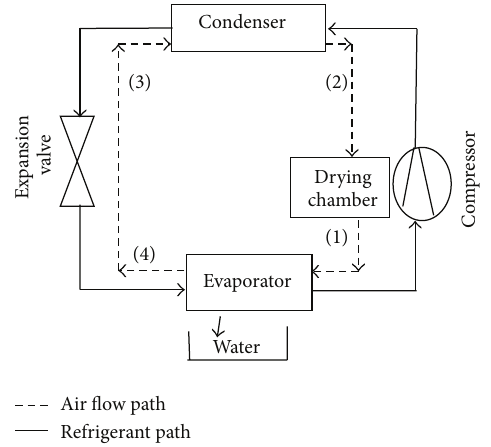
Figure 2: Component arrangement of a heat pump